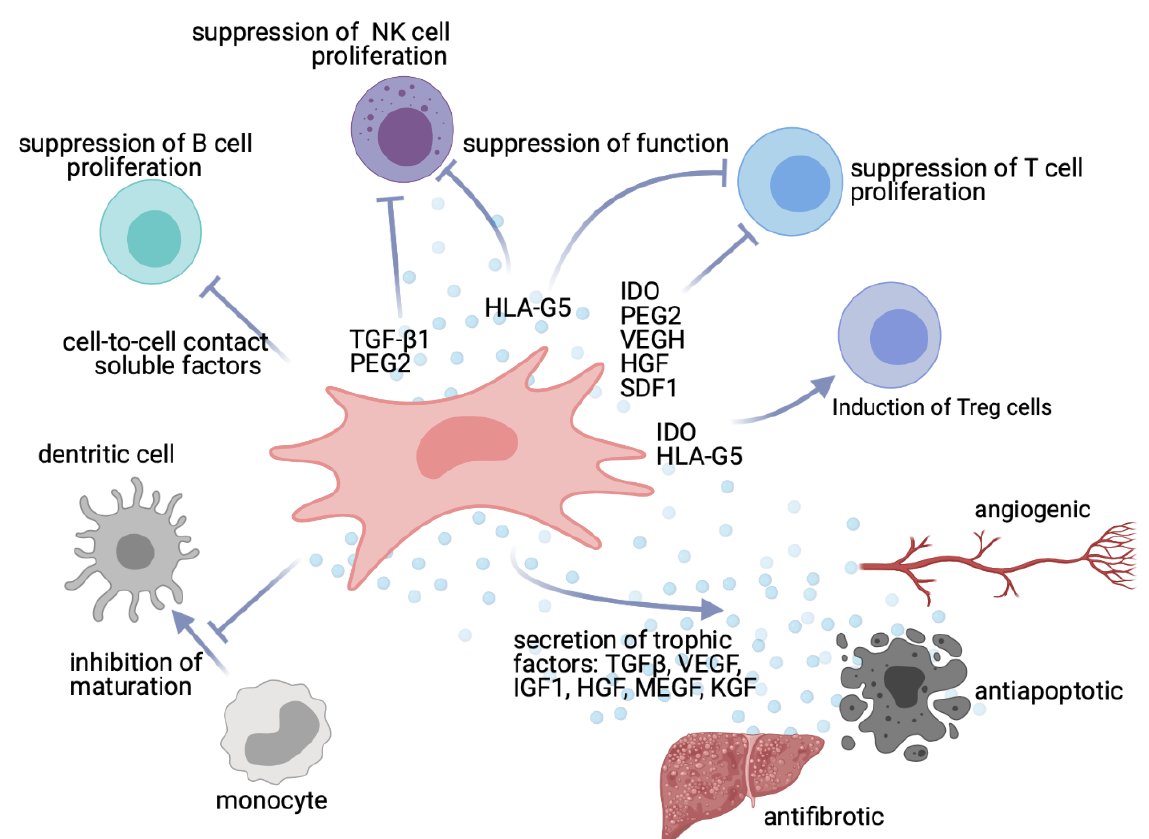
Figure 1. Effects of MSCs on organ regeneration through immunomodulatory and other effects. MSCs suppress T cell, B Figure 1: Effects of MSCs on organ regeneration through immunomodulatory and other cell, and natural killer (NK) cell proliferation. They may induce regulatory T cell differentiation via secretion of indoleamine effects. 2,3-dioxygenase (IDO) and human leukocyte antigen-G5 (HLA-G5), have an impact on the maturation of monocytes into dendritic cells, and inhibit NK and T cell function. Through secretion of soluble factors, such as growth factors, cytokines, and chemokines, MSCs contribute to tissue repair, promote angiogenesis, and prevent cell apoptosis and formation of fibrosis. (Figure created with https://biorender.com, accessed on 21 March